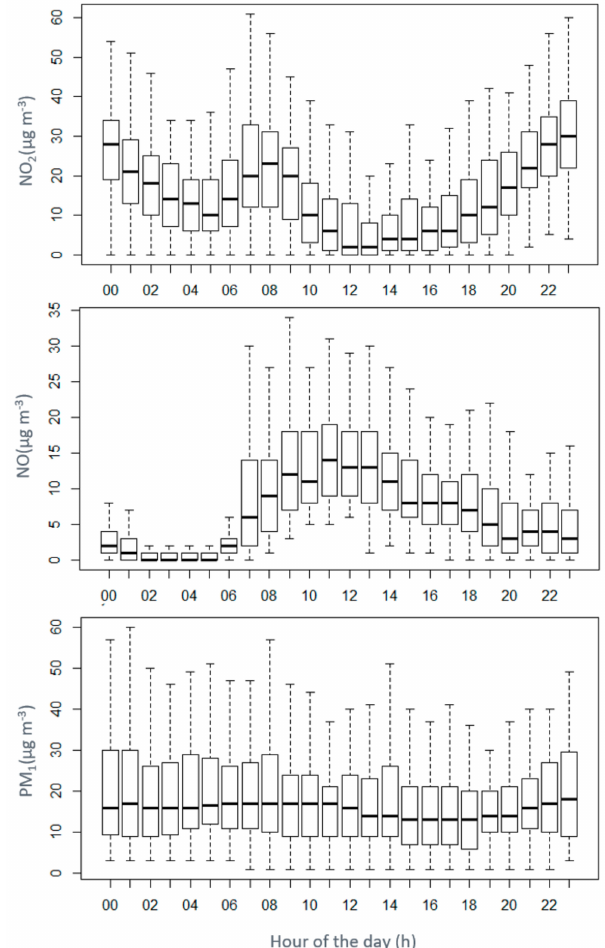
Figure 9. Hourly NO 2 (Kunak; upper), NO (Kunak; middle) and PM 1 (Airly; lower) variability as observed at the Grote Markt 1